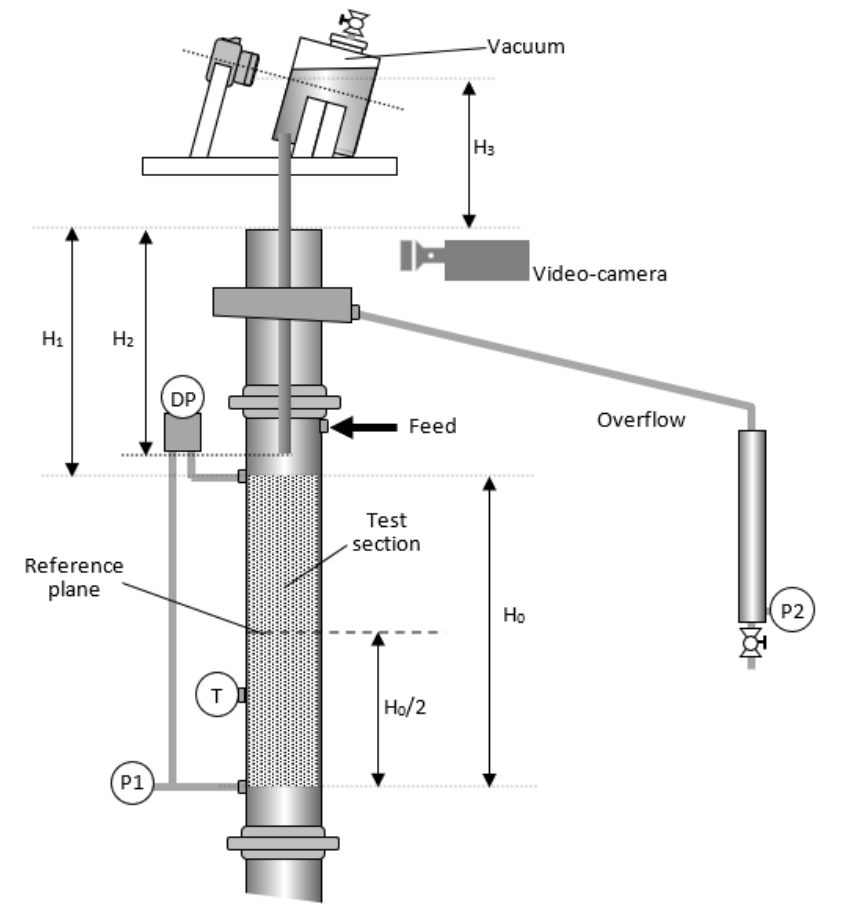
Figure 7. Relevant lengths and distances in the measurements of gas dispersion variables in a laboratory flotation column.